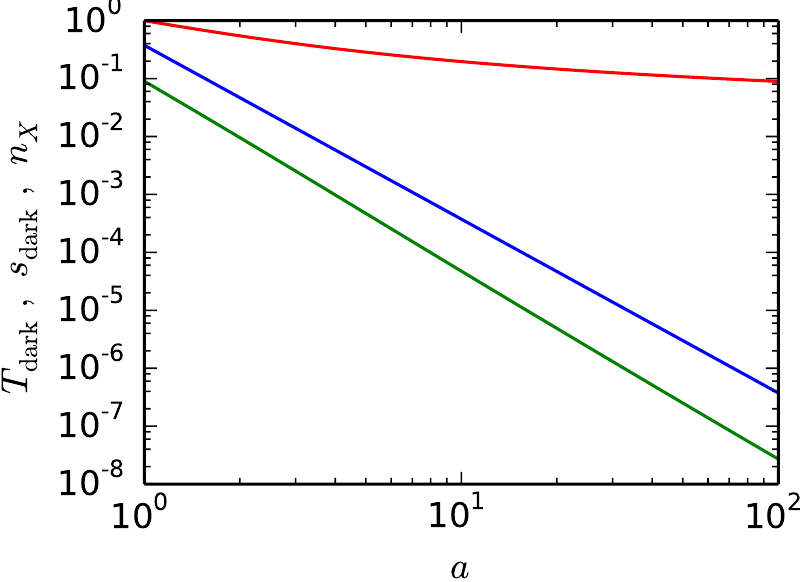
Figure 1 . The red, blue, and green lines show T dark (normalized by Λ ), s dark (normalized by Λ 3 ), and n (normalized by Λ 3 ) as functions of the scale factor, assuming the chemical equilibrium; dark the scale factor is normalized as a | = 1 T dark =Λ